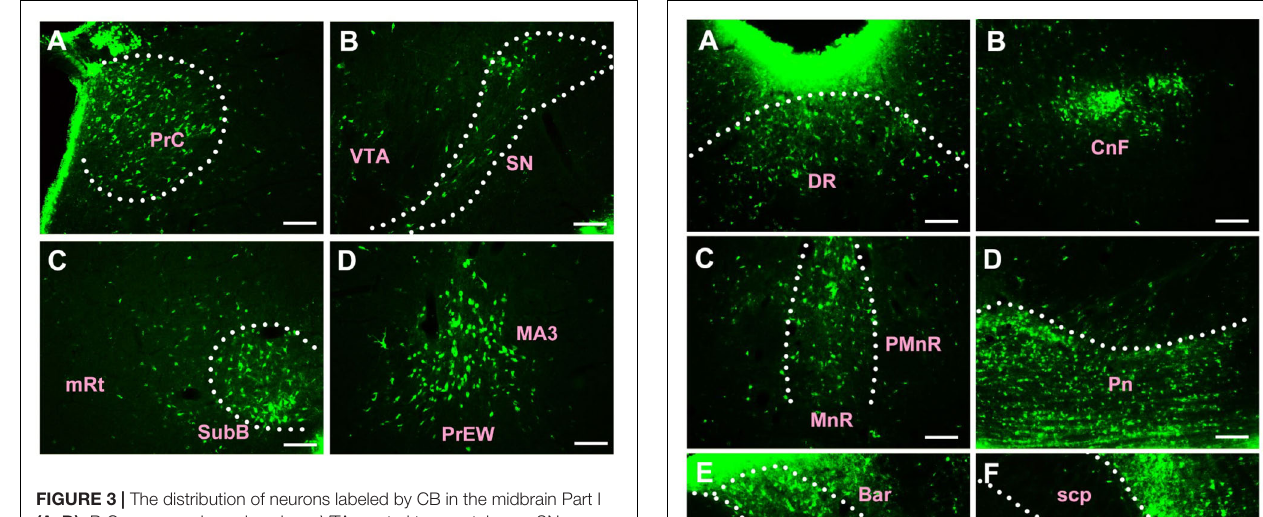
FIGURE 3 | The distribution of neurons labeled by CB in the midbrain Part I (A–D) . PrC, precommissural nucleus; VTA, ventral tegmental area; SN, substantia nigra; mRt, mesencephalic reticular formation; SubB, subbrachial nucleus; MA3, medial accessory oculomotor nucleus; PrEW, pre-Edinger-Westphal nucleus. Scale bar = 100 µ m.